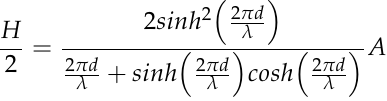
Table 6. Comparison of steady amplitude with a different method.